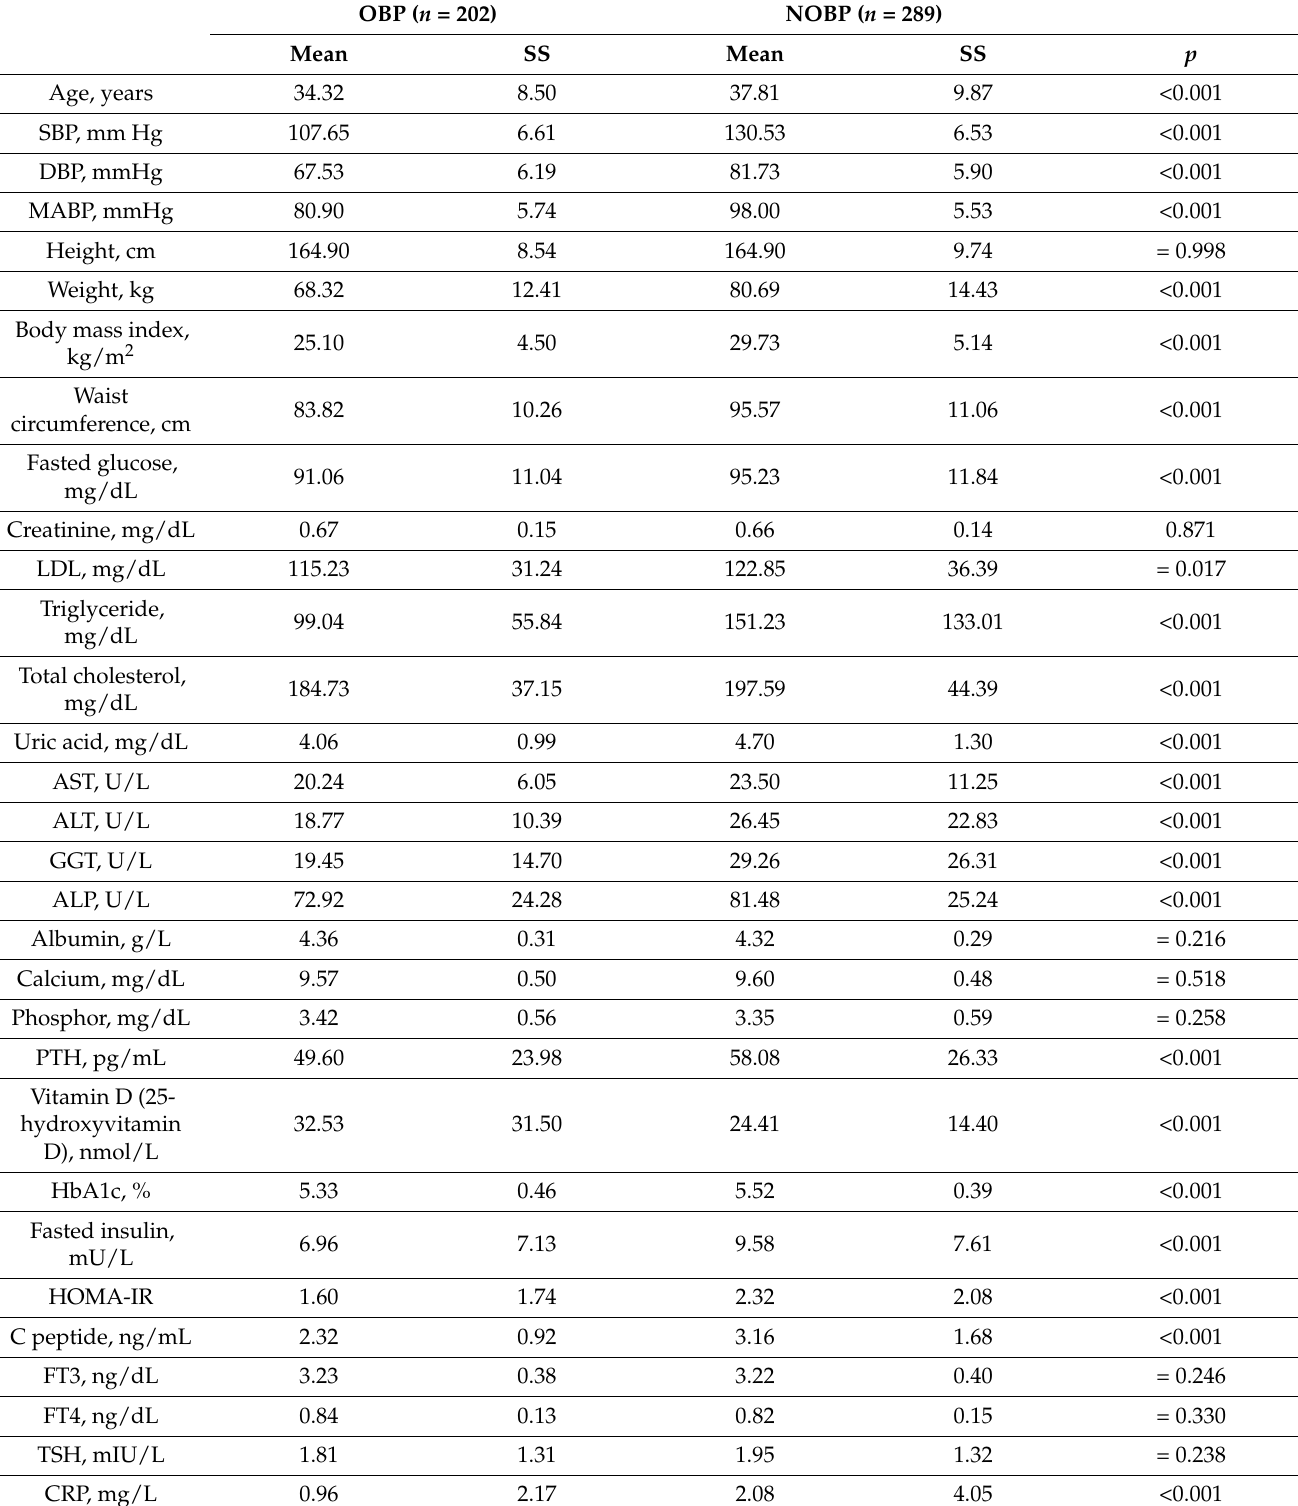
Table 1. Comparison of anthropometric, blood pressure, and metabolic parameters between NOBP and OBP